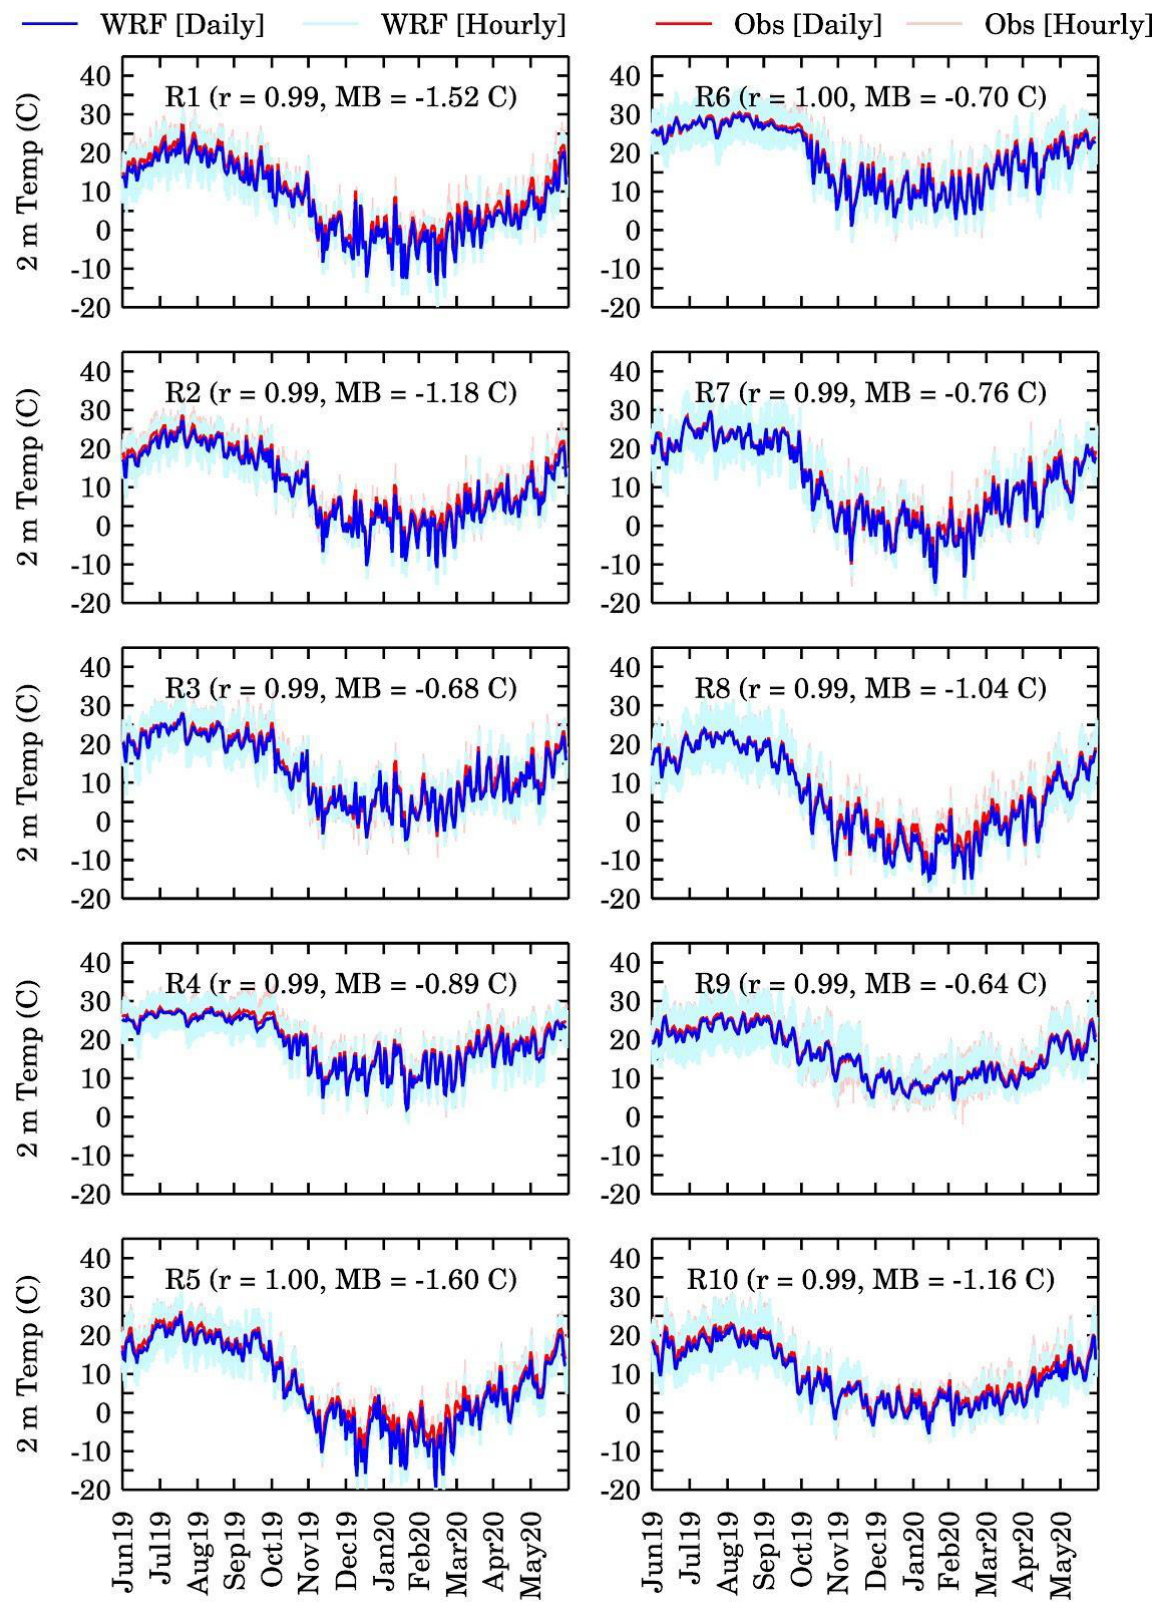
Figure 4. Seasonal variations in hourly and daily observed and model-simulated 2 m temperature in 10 EPA regions during June 2019 to May 2020. Pearson correlation coefficient (r) and mean bias (MB) for each region estimated using paired data for the full year are also shown.